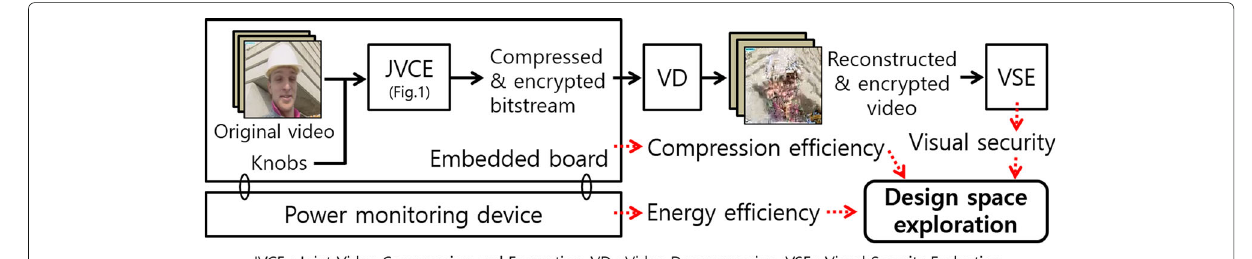
Fig. 2 Design space exploration framework of the JVCE regarding visual security, compression efficiency, and energy efficiency. This figure shows the experimental framework that we construct for the design space exploration of the JVCE. The framework consists of the embedded board for running the JVCE with various parameters, the power monitoring device for estimating the energy consumption of the JVCE, and the desktop for estimating the visual security of the encrypted videos after the